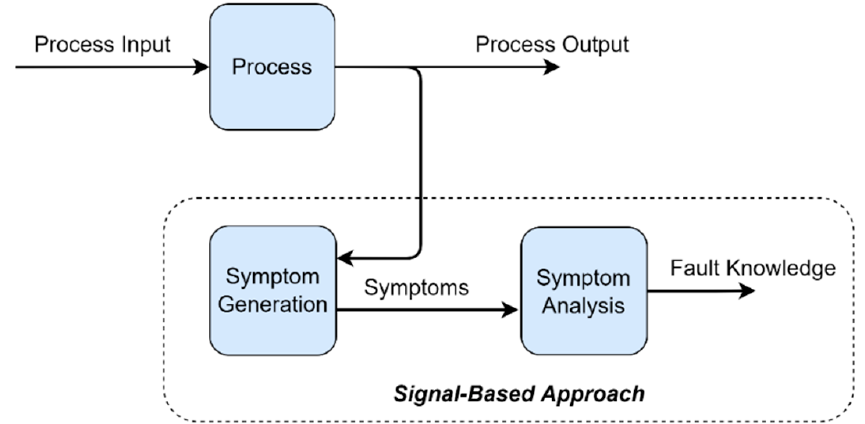
Figure 9. A summary of the signal-based approach used for fault detection. Adapted from [92].